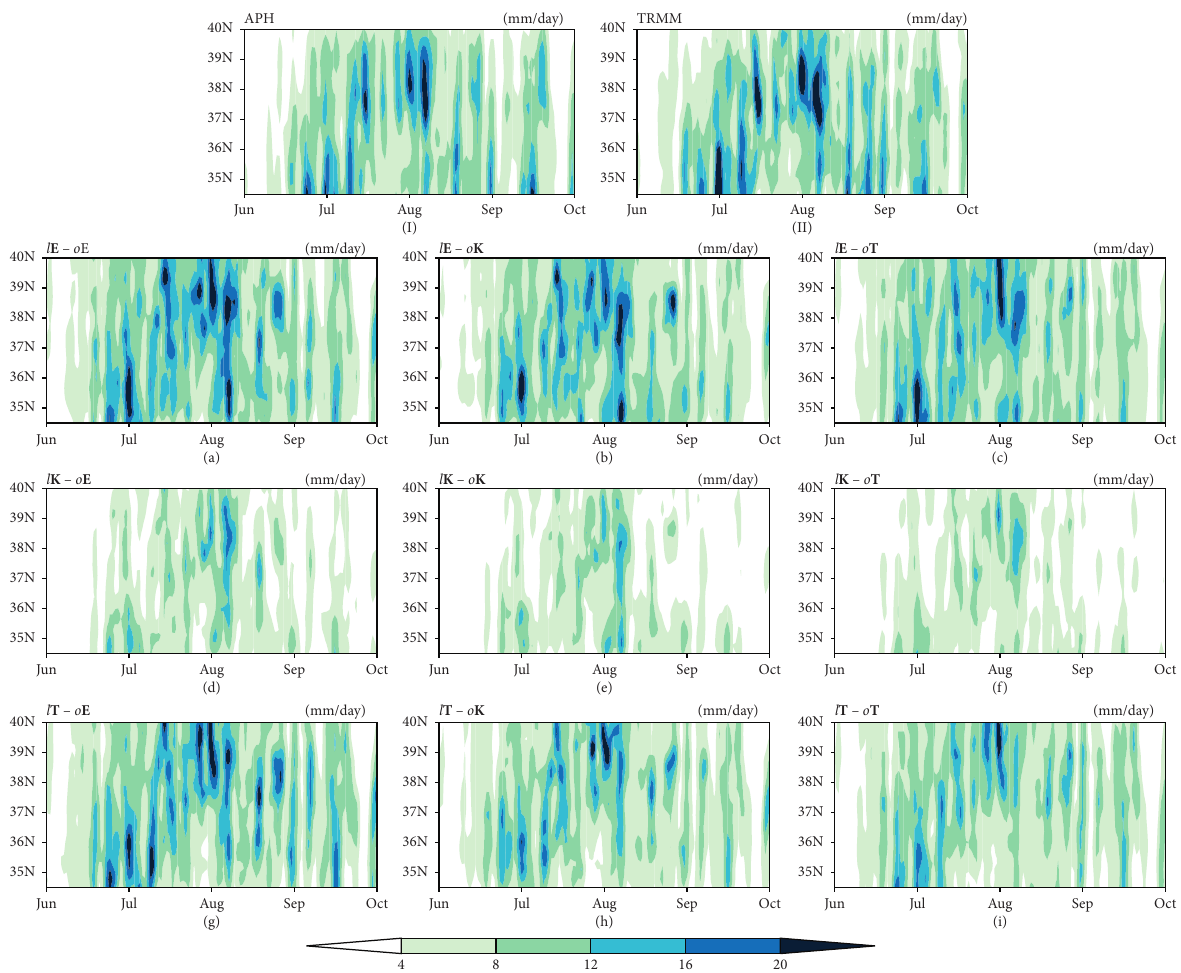
Figure 5: Time-latitude cross-sections of the 10-year JJAS period (1998–2007) mean daily precipitation (mm/day), zonally averaged over the Korean Peninsula (126 ° E to 129.5 ° E), derived from: (I) APHRODITE, (II) TRMM, and (a)–(i) model